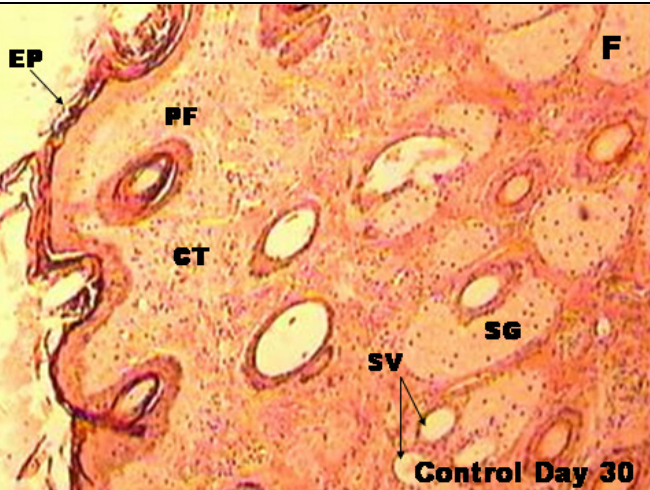
FIGURE 8 - Control group at Day 30 showing the epidermis (EP). The dermis shows connective tissue (CT) with sebaceous glands (SG) and pilous follicles (PF) and small vessels (SV). 5 x